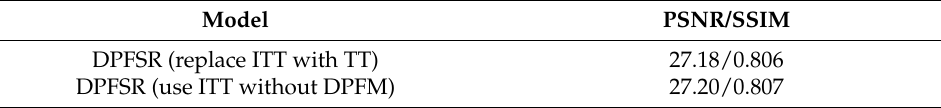
Table 3. Ablation study on improved texture